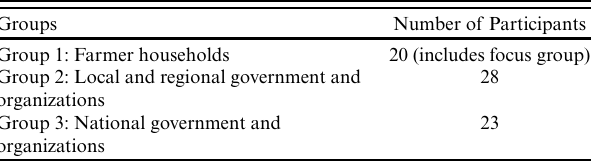
Table 3 . Distribution of